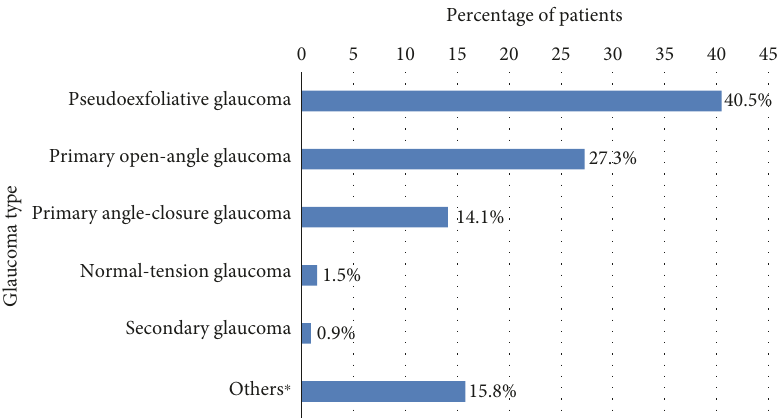
Figure 2: Pro fi le of diagnosis of glaucoma among patients attending the glaucoma clinic of Menelik II Hospital, 2015. ∗ Ocular hypertension, juvenile glaucoma.